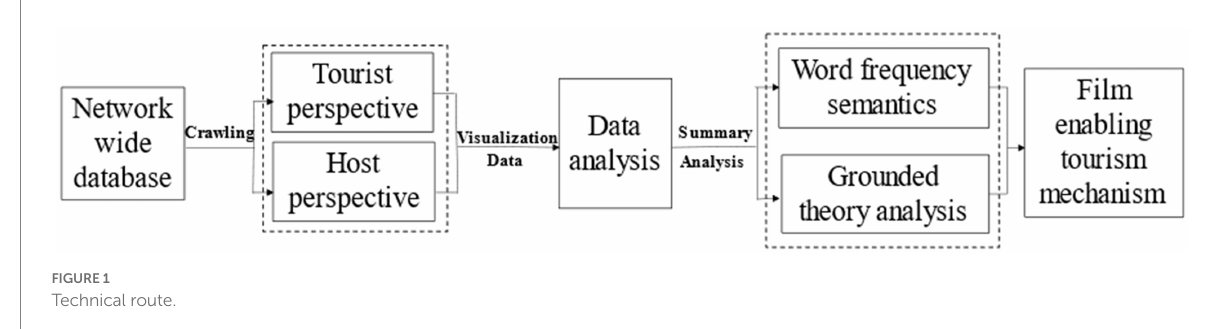
FIGURE 1 Technical